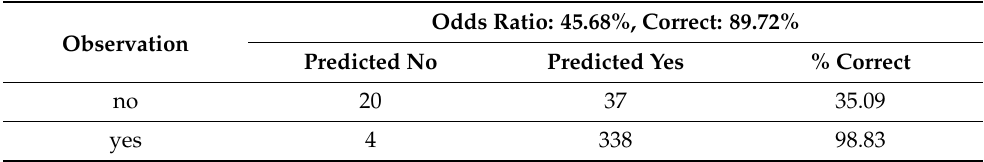
Table 5. Classification of motivations behind healthy eating habits among young